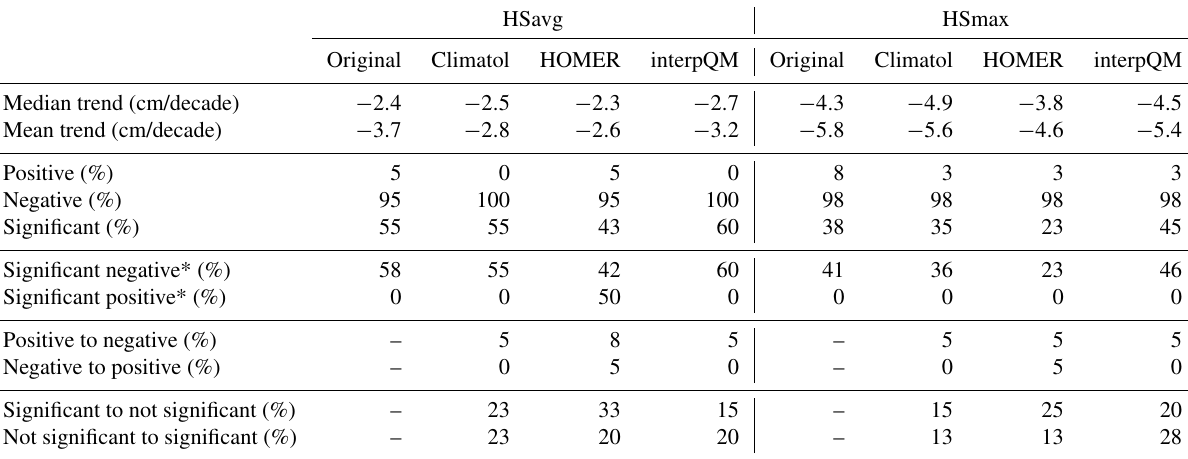
Table 3. Statistics for trends of HSavg and HSmax for the period 1961 to 2021.